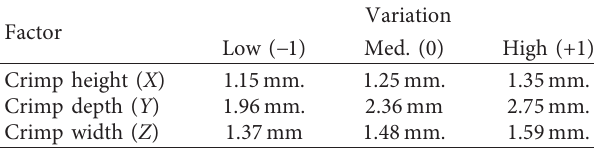
Table 1: Parameters for experimental design.